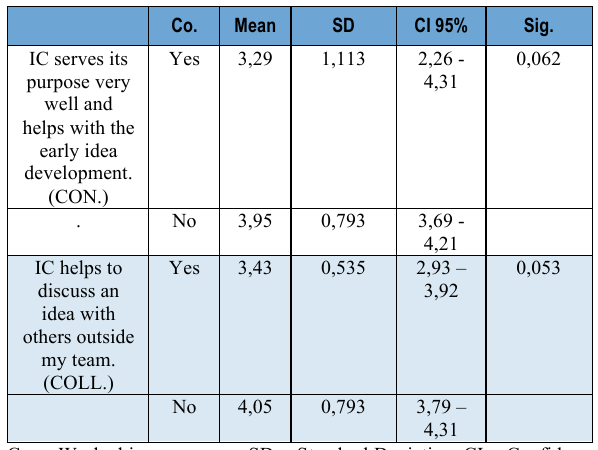
Table 2. Statements that significantly differ for researchers